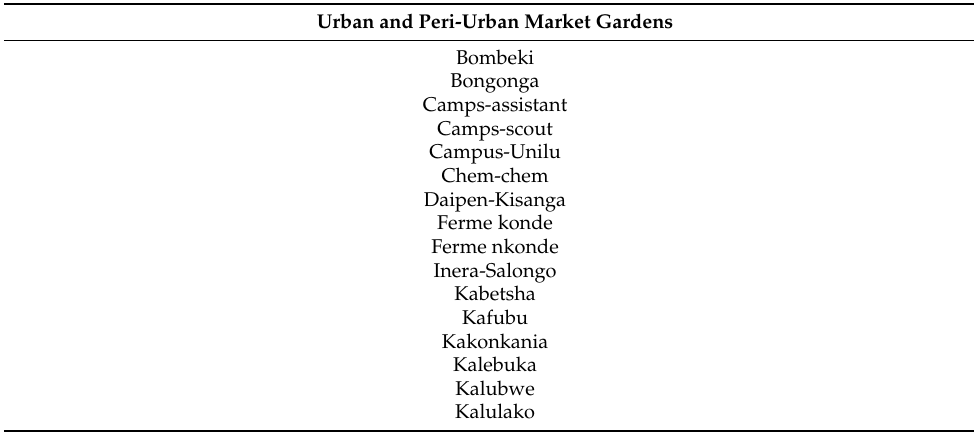
Table A1. Urban and peri-urban gardens identified in